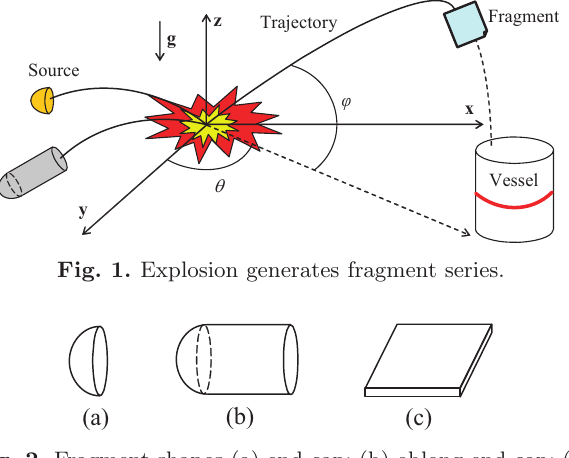
Fig. 2. Fragment shapes (a) end-cap; (b) oblong end-cap; (c) plate.